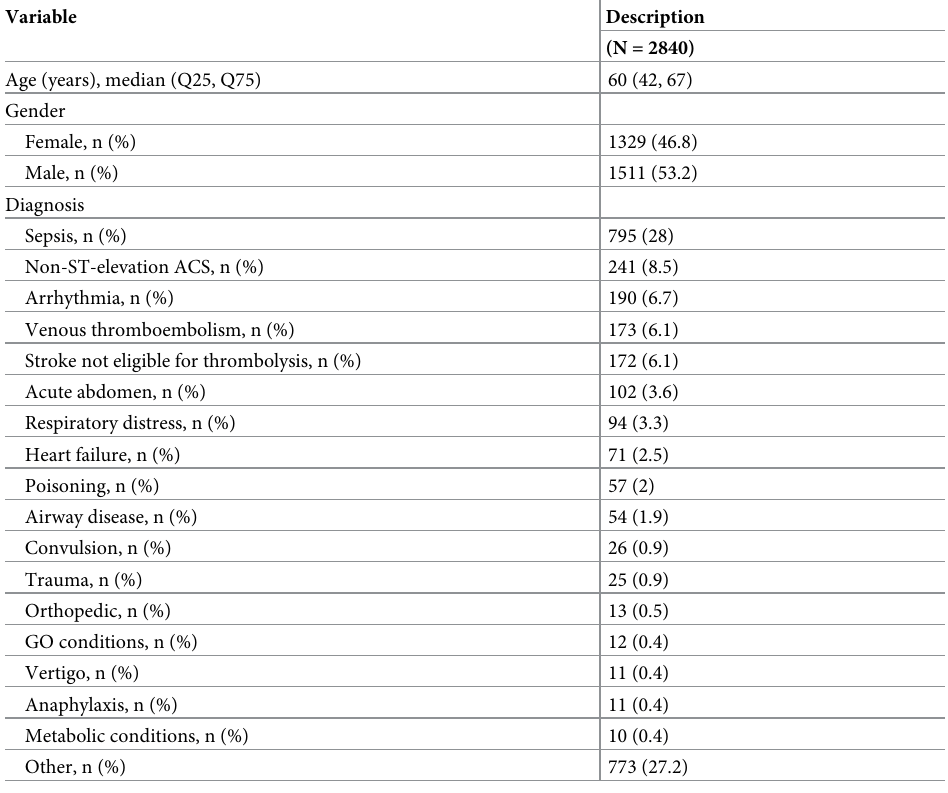
Table 1. Demographic data and